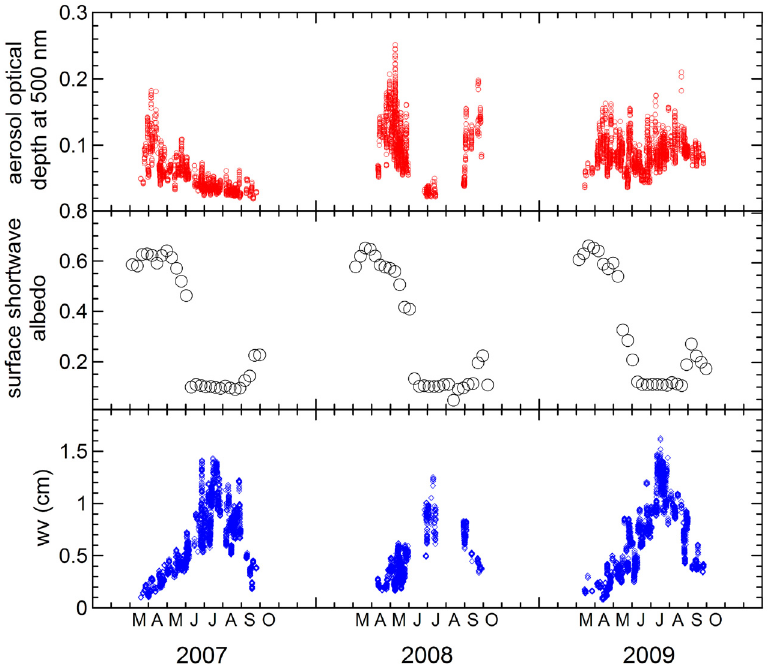
Figure 10. Top panel: aerosol optical depth at 500 nm. Bottom panel: column water vapour (wv) derived from Cimel observations. Center panel: MODIS derived 8-day surface shortwave albedo during the period March-October of the years